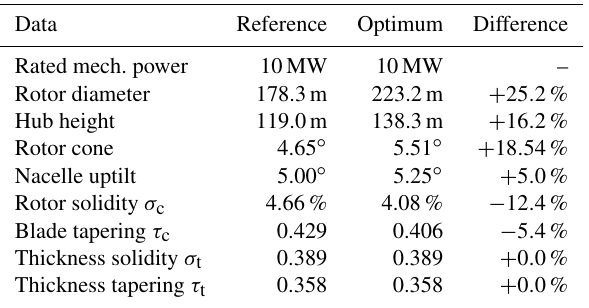
Table 10. Summary of design parameters p g for the holistic opti- mization of the 10MW onshore wind